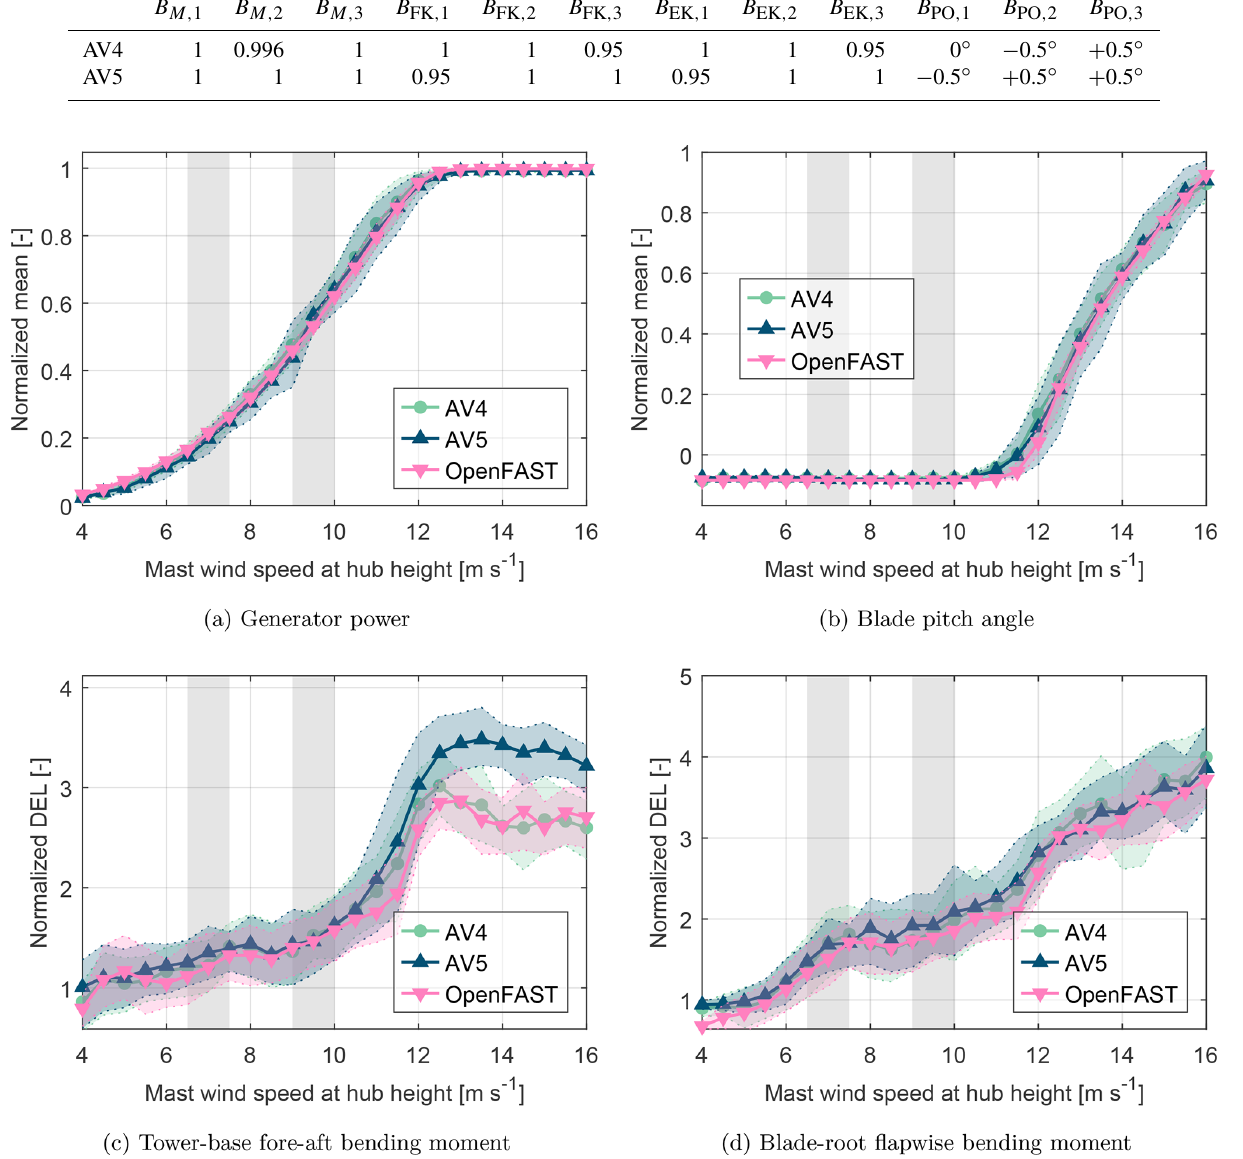
Figure 3. Comparison of freestream (wind direction 240–257 ◦ ) characteristics between measurements (AV4, AV5) and simulations (Open- FAST: results are shown with calibrations based on AV4). Statistics are shown as mean values per wind bin. The shaded area indicates the 15th and 85th percentiles. Patches in grey show the wake bins I and II analyzed in Sect.